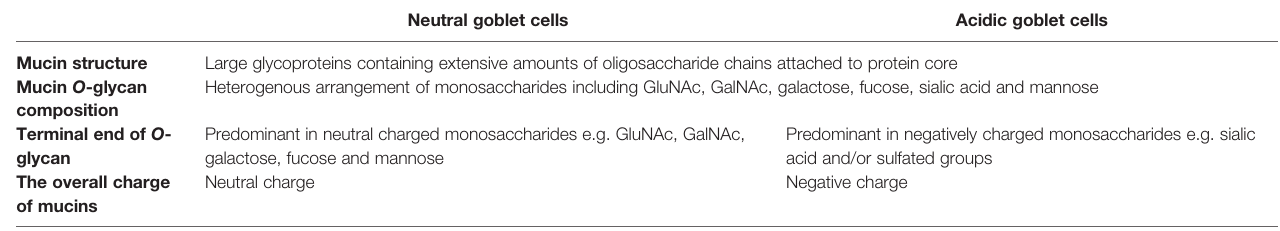
TABLE 1 | Characteristics of neutral and acidic goblet cells a